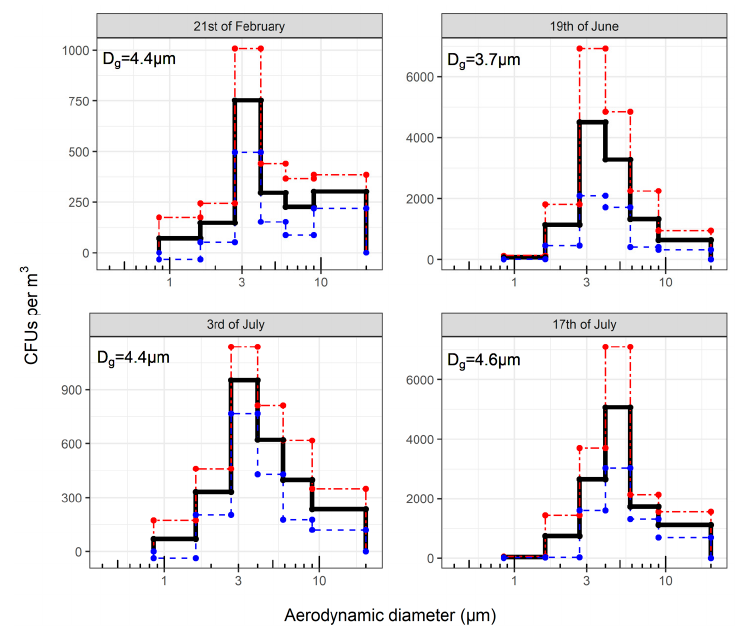
Figure 1. Histograms of averaged CFU size distributions from each sampling day. Horizontal black lines represent the mean CFU concentration within the size bin with the standard error ( σ ) in red and blue for the + σ and −σ , respectively. The overall calculated the geometric mean aerodynamic diameter (D g ) of that sampling day is written at the top left corner of each plot. Sampling on different days did not affect the measured D g of fungal aerosols as sampled with the ACI-6. On the 21st of February, 19th of June, and 3rd of the July, the airborne fungal size Atmosphere 2020 , 11 , x FOR PEER REVIEW distributions had D g ‘s corresponding to a size range between 2.7 µm and 4.0 µm. On the 17th of July, the maximum shifted to a larger particle size bin ranging 4.0 µm and 5.85 µm (Figure 1). However, the differences in D g were not significantly different between the sampling days ( p = 0.31). Overall, the mean percentage of fungal CFUs classifiable as respirable was 69% ± 7. During the different sampling rounds, the calculated D g of particles with fungi was observed to significantly increase with the number of sampling rounds ( p < 0.001). No significant differences in the D g of particles with fungi were found between days when the pigs were and were not sprinkled ( p = 0.37), and the D g of particles with fungi did not significantly change between rounds where the pigs and stables were sprinkled ( p = 0.37).